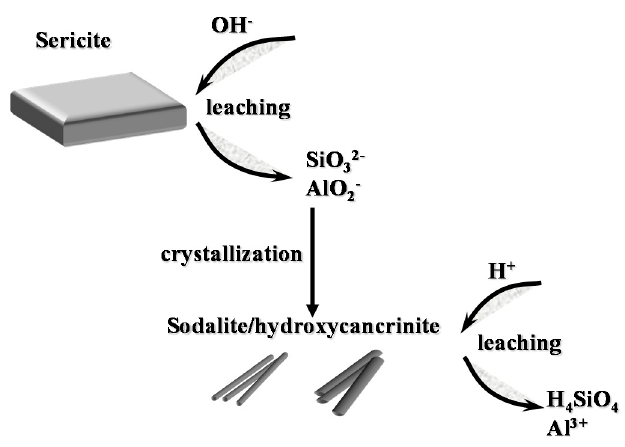
Figure 10. Schematic diagram of the dissolution mechanism of sericite by alkali-acid leaching.